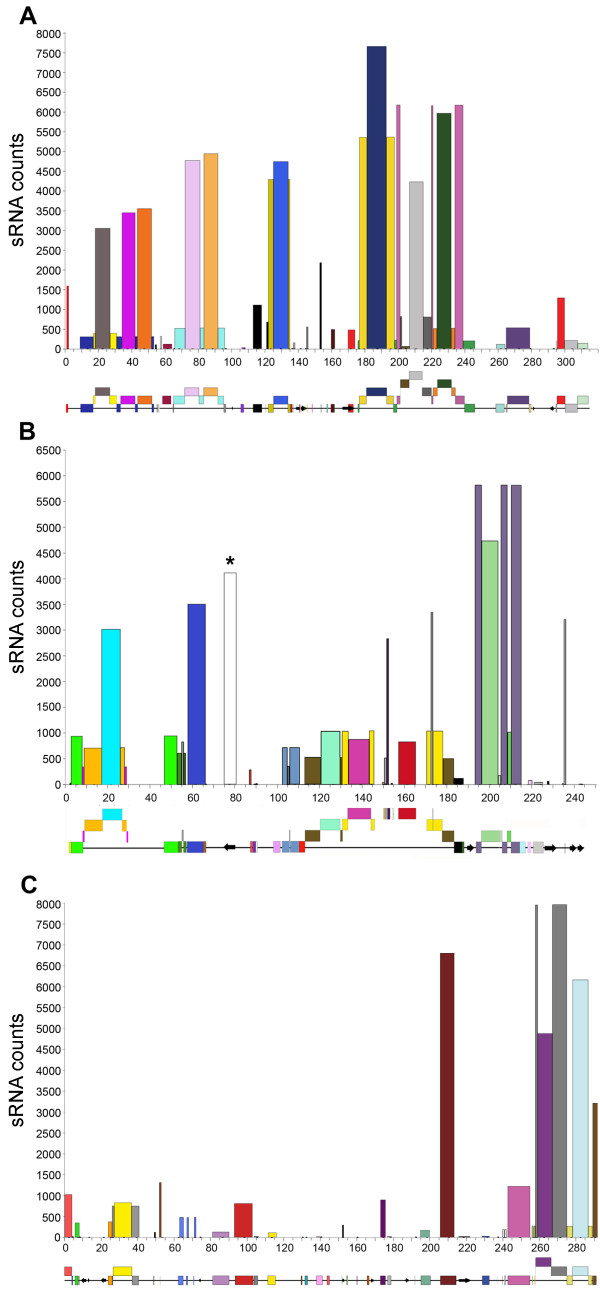
sRNA counts over annotated genomic regions. Bar graphs representing the total counts of sRNA that perfectly matched annotated TEs and genes in EU835198 (A), DQ871219 (B), and EF540321 (C). sRNA counts and size of the annotated locus to which the sRNAs match correspond to bar height and bar width, respectively. A graphical representation of the structure of the genomic regions is provided below each bar graph. TEs are shown as colored boxes and genes as arrows. More recent insertions of repetitive elements are shown as boxes nested above the elements into which they were inserted. Boxes of the same colour and at the same level are part of the same element. In Figure 1B the bar with asterisk corresponds to the total counts of sRNAs from library TAE4 matching the RNAi target (TaNAM) gene.